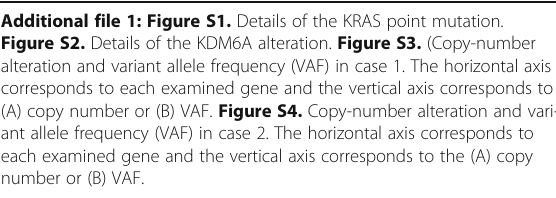
Additional file 1: Figure S1. Details of the KRAS point mutation. Figure S2. Details of the KDM6A alteration. Figure S3. (Copy-number alteration and variant allele frequency (VAF) in case 1. The horizontal axis corresponds to each examined gene and the vertical axis corresponds to (A) copy number or (B) VAF. Figure S4. Copy-number alteration and vari- ant allele frequency (VAF) in case 2. The horizontal axis corresponds to each examined gene and the vertical axis corresponds to the (A) copy number or (B) VAF. Additional file 2: Table S1. Genes (160) examined in the PleSSision